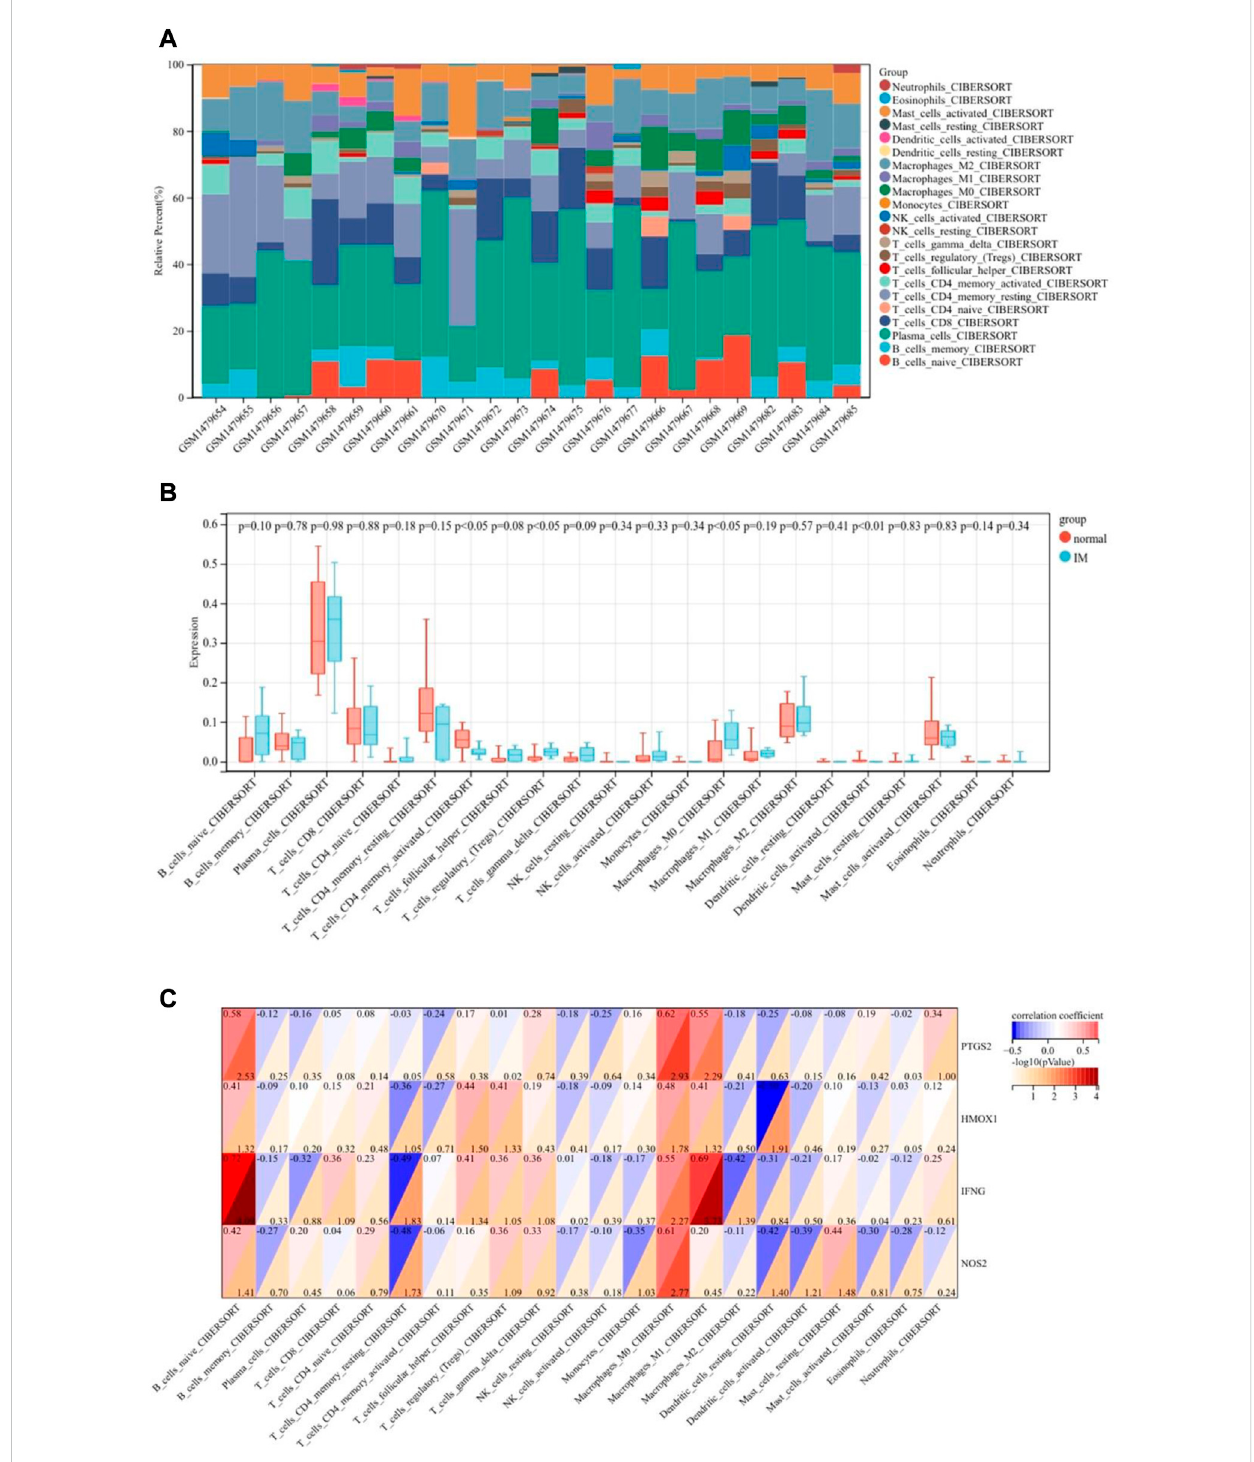
FIGURE 9 Immunelandscapeanalysis. (A) Barchartsof22immunecellproportions. (B) Differentialimmunecellin fi ltrationbetweenIMandcontrolgroups. (C) Correlation between differentially in fi ltrated immune cells and hub